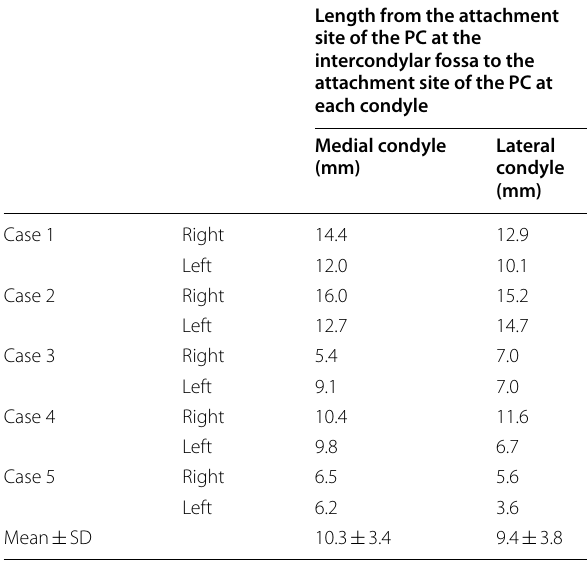
PC posterior capsule, SD standard deviation